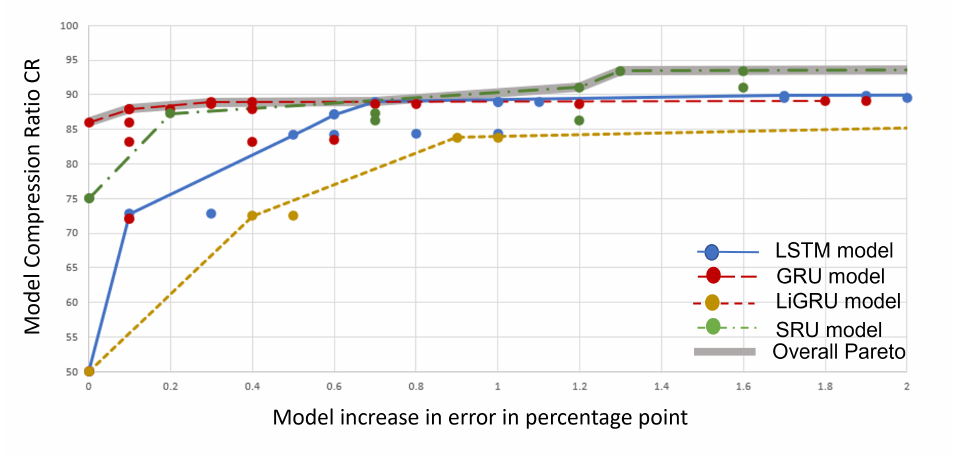
Figure 5. Compressability plot. For each model, the compression ratios for different quantization configurations are plotted against the increase in error compared to each model’s baseline error. The best solutions are connected in a line. The gray shadow highlights the best points among all models.